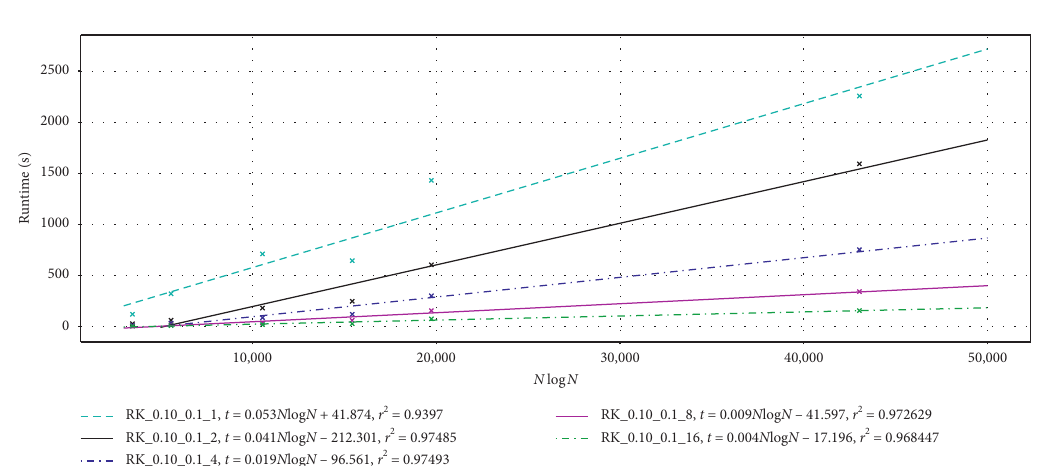
Figure 11: Runtime regrading different k settings; x -axis is N ∗ log N , where N is the size of the